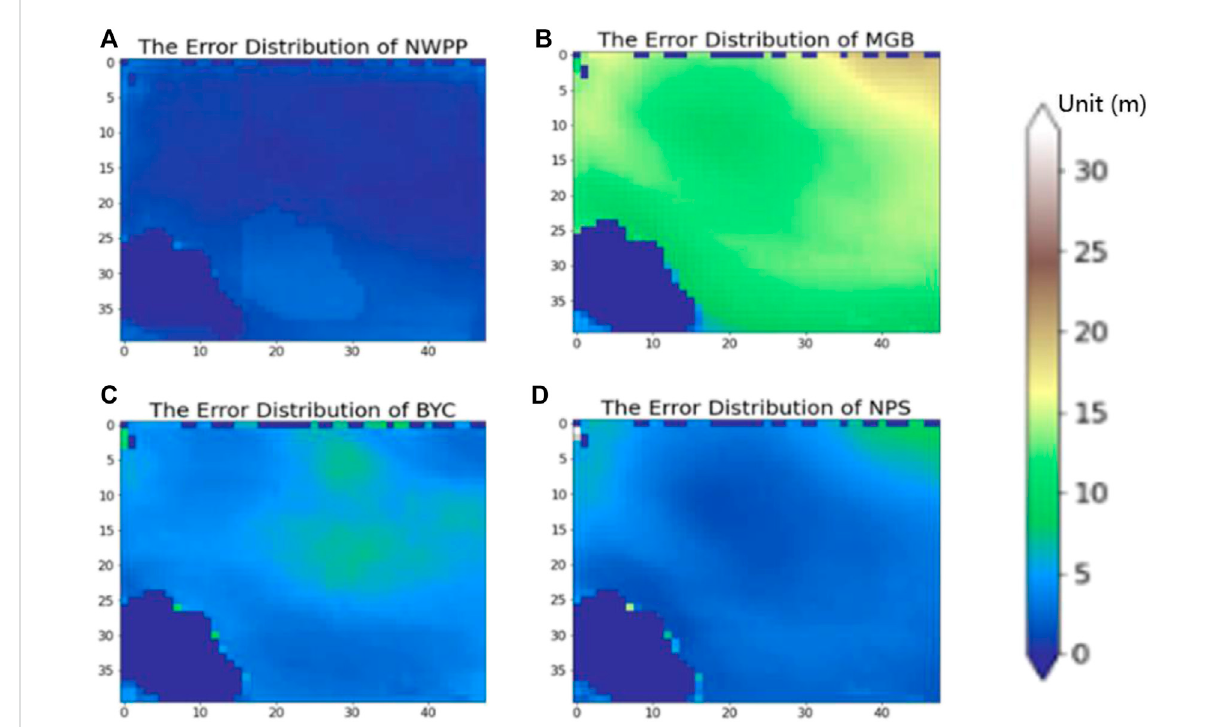
FIGURE 4 Error distributions of the four models: (A) the NWPP-EDH model, (B) is the MGB model, (C) the BYC model, and (D) the NPS model.